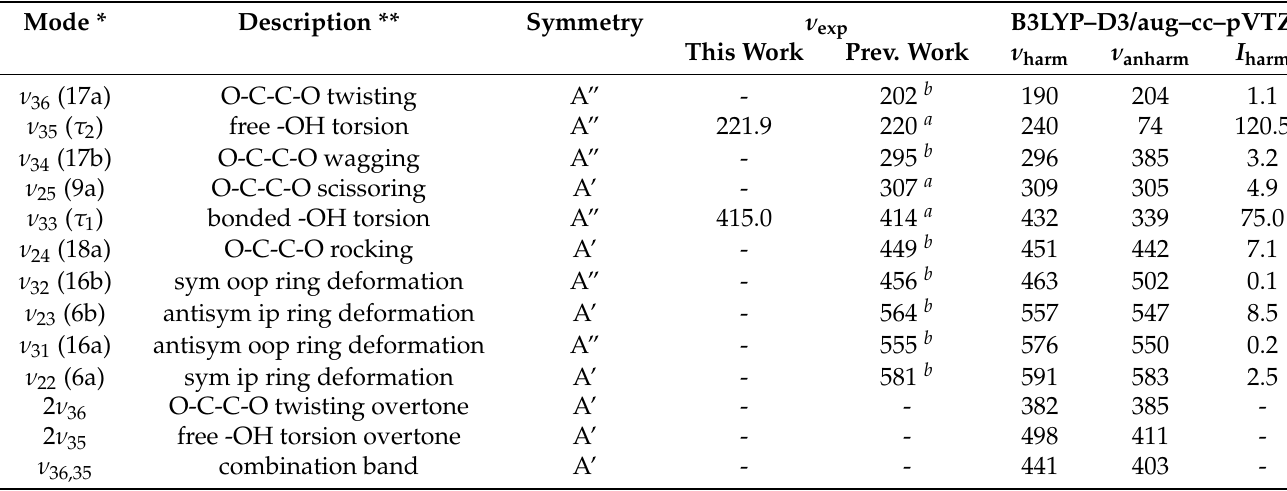
* In parentheses, the vibrational labelling used for monosubstituted benzenes [23] and used in previous catechol studies [16,17]. ** Twisting and wagging correspond, respectively, to antisymmetric and symmetric out-of-plane (oop) bending modes; Scissoring and rocking correspond respectively to symmetric and antisymmetric in-plane (ip) bending modes. a REMPI low-resolution gas phase vibrational measurements from [4]. b Solid state IR and Raman measurements from